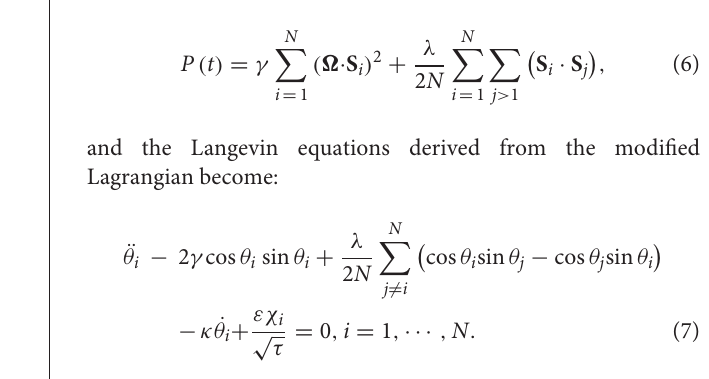
FIGURE 1 | Sketch of the Standard “Domino” model (adapted from Mori et al.,